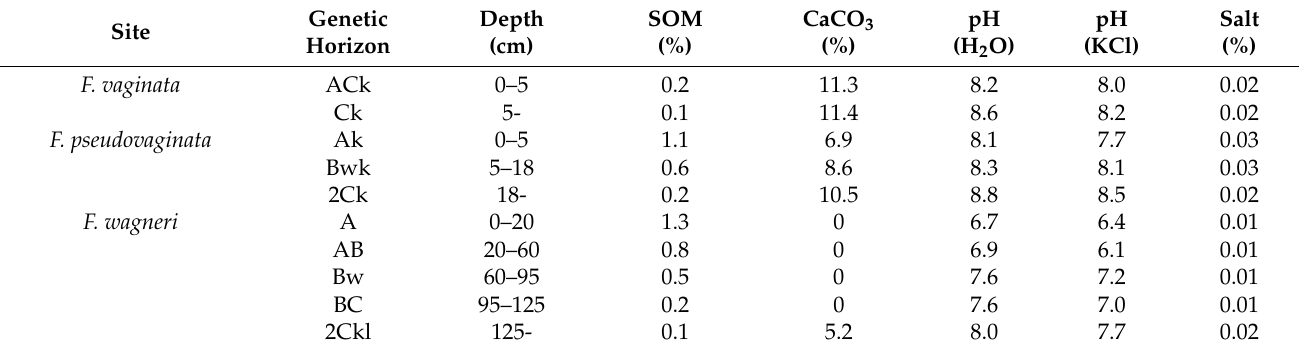
Table 1. Basic soil chemical parameters of the genetic horizons of the soils profiles sampled under F. vaginata, F. pseudovaginata and F. wagneri sites.